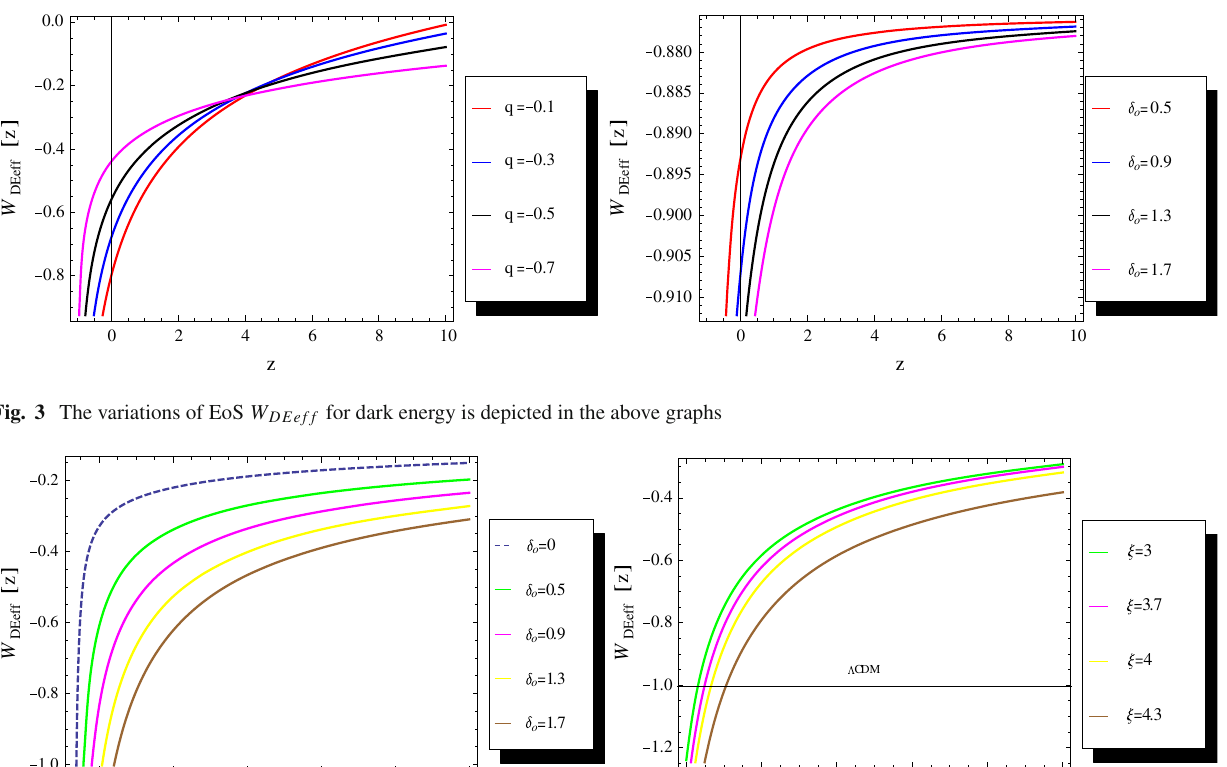
for η = 1, h = 3 / 2, k = 3 / 4, e = 5 / 2, q = − 0 . 1, ρ o = 0 . 9, a o = 1, ω = 0, ξ = 2 and δ = 1 . 5 (panel in right o